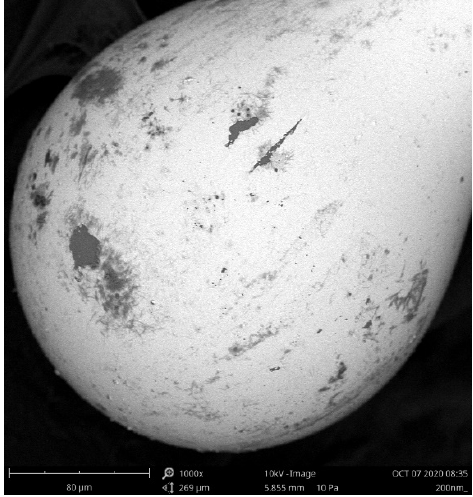
Figure 1. SEM image of the microsphere sensor with a 100 nm ZnO ALD coating. Magnification of 1000×.